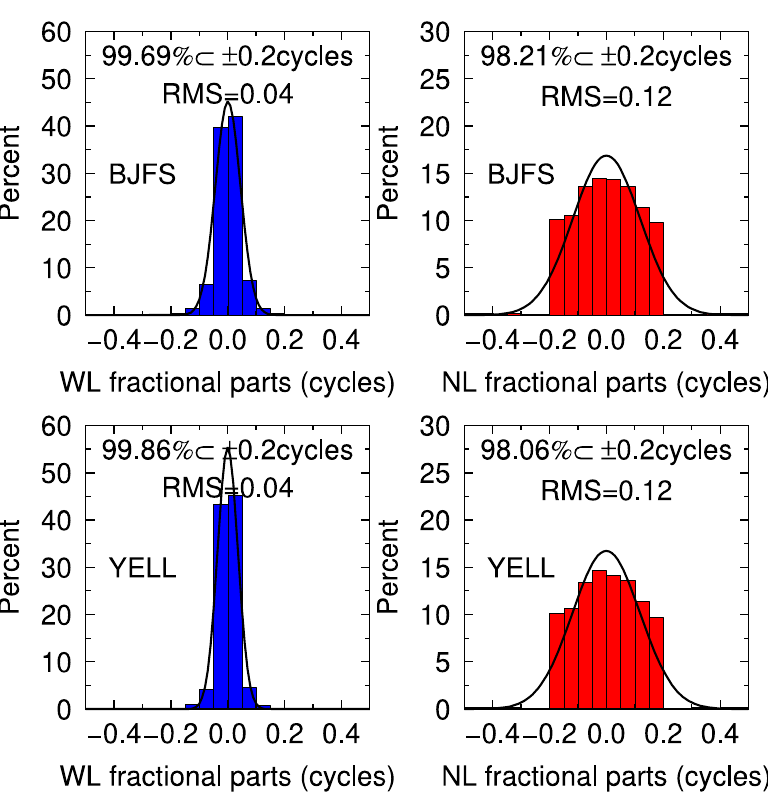
Figure 6. Distribution of the fractional parts of all the WL and NL ambiguities for BJFS and YELL on the whole year of 2018.